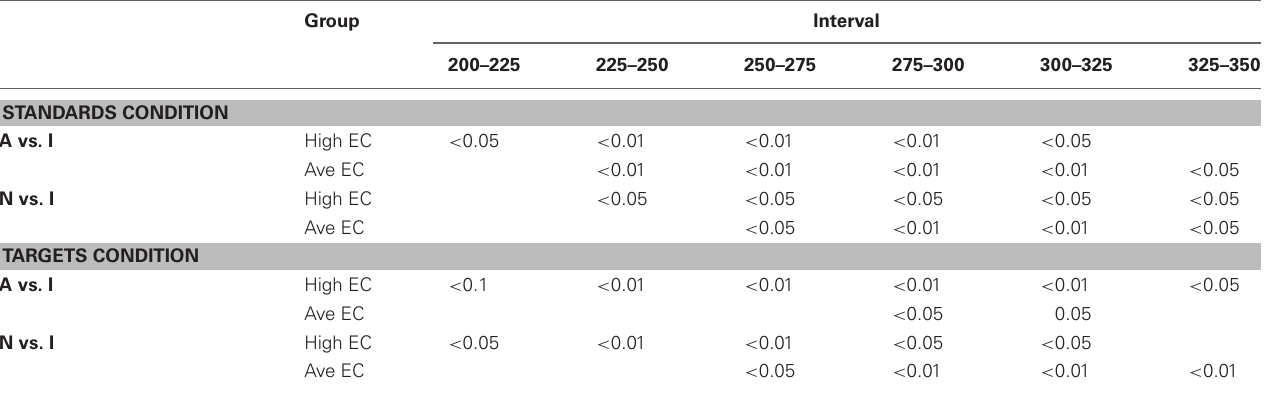
Table 3 | Selection negativity.